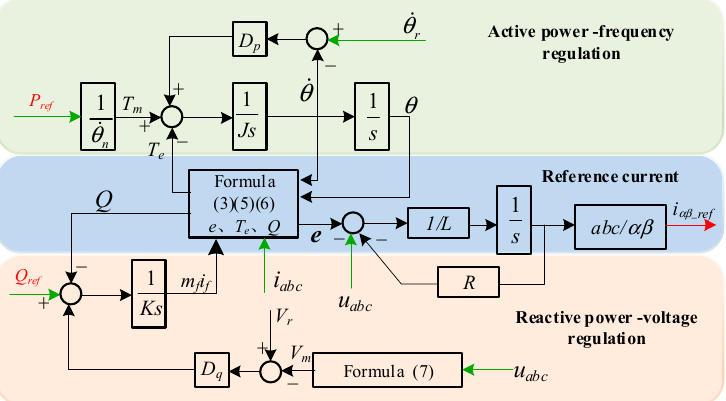
Figure 2. The control structure of the VSG.